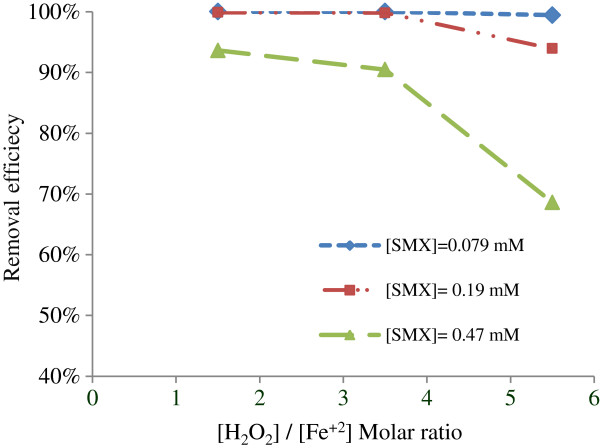
Effect of [H2O2]/[Fe+2] molar ratio on antibiotic removal: [H2O2] = 1.47 mmol/L, [Fe+2] = varying, pHo= 2.5, retention time= 15 min. The standard deviation of all data points was below 3.5.